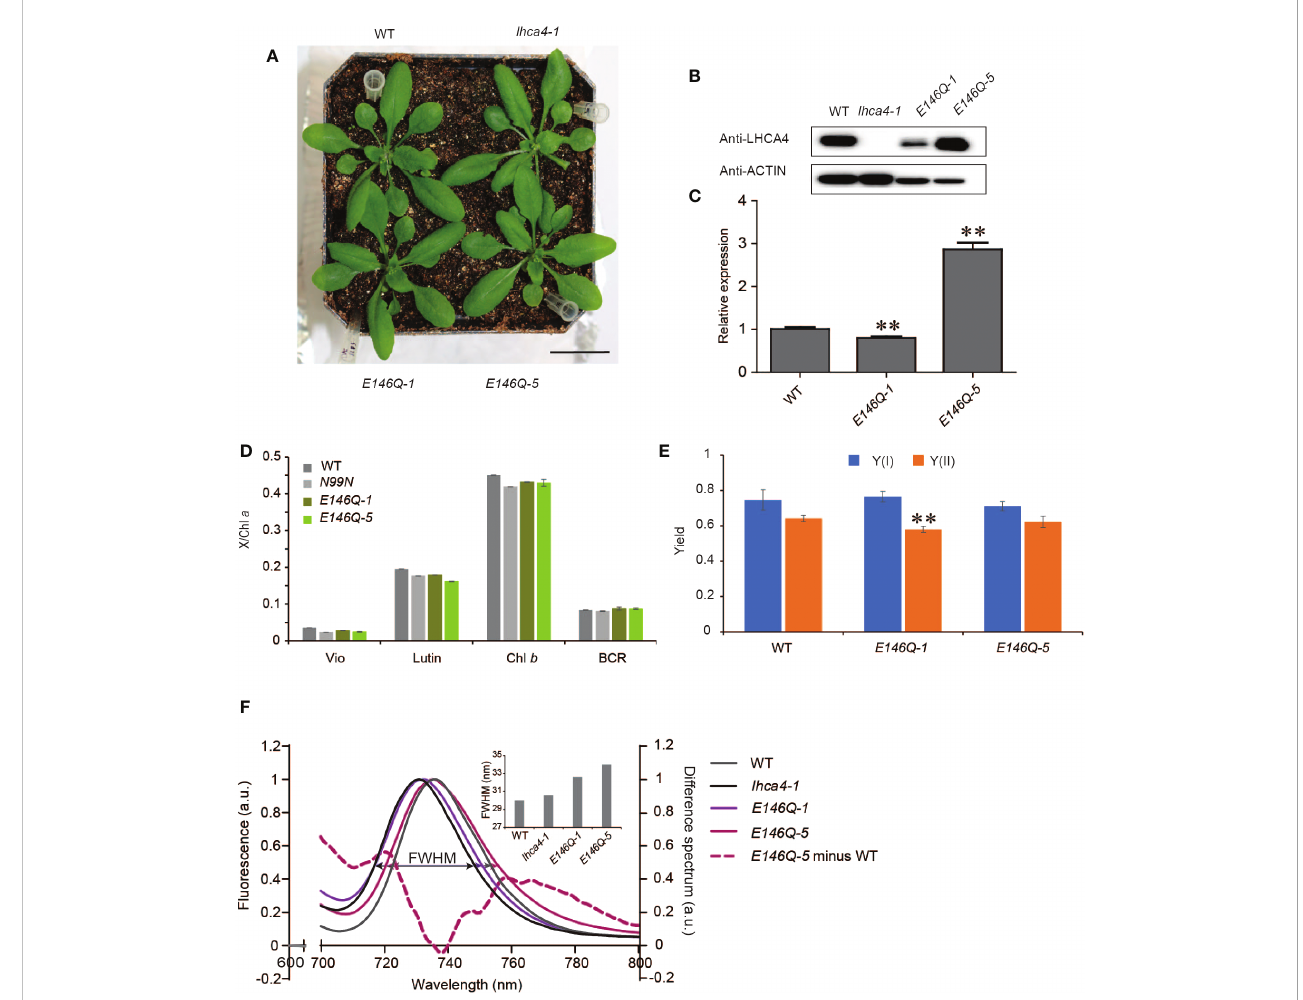
FIGURE 5 Characterization of LHCA4(E146Q) point mutant lines. (A) Phenotype of the WT, lhca4-1 , and two LHCA4(E146Q) point mutant lines, 35S:LHCA4 ( E146Q ) - 1 and 35S:LHCA4 ( E146Q ) -5 (scale bars = 2 cm). (B-C) LHCA4 abundance as detected by immunoblot analysis. Anti-ACTIN antibodies were used for the immunoblots assays. (B) and relative LHCA4 expression levels as detected by RT-qPCR (using the two-tailed Student ’ s t-test; **signi fi cant at P < 0.05) (C) in the WT, lhca4-1 , and LHCA4(E146Q) point mutant lines. (D-E) Pigment composition (D) and chlorophyll fl uorescence parameters Y(II) and Y(I) (E) of the WT and LHCA4(E146Q) point mutant lines (using the two-tailed Student ’ s t-test; **signi fi cant at P < 0.01). (F) Low-temperature (77K) fl uorescence emission spectra (excited at 440 nm) of the WT (gray), lhca4-1 (black), 35S:LHCA4 ( E146Q ) -1 (light purple), and 35S:LHCA4 ( E146Q ) -5 (dark purple). The purple dotted line shows the difference between the spectra of 35S:LHCA4 ( E146Q ) -5 and the WT (and multiplied by 5 to facilitate comparison). The FWHMs (full widths at half maximum) for each line are labeled and marked with double arrows in the same colors as the